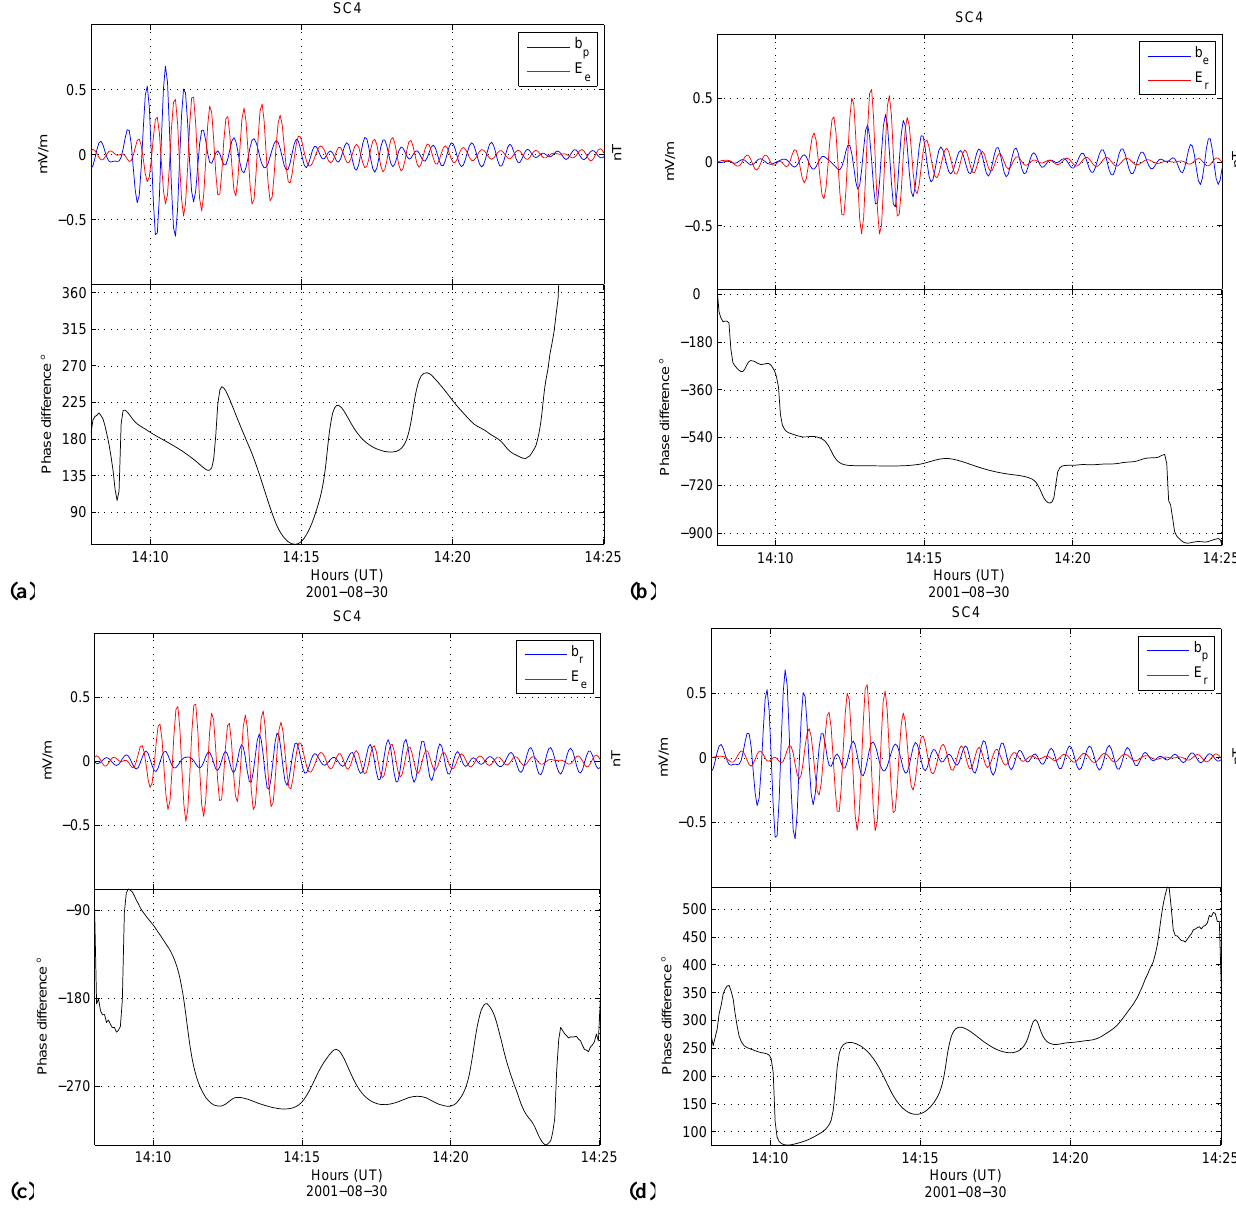
Fig. 8. Same as Fig. 7 but bandpass filtered with passband 22–32mHz. for the first five or six wave periods and then the amplitude starts to decrease. The magnetic field component does not show the same rate of increase as the electric field compo- nent. The phase difference between the two components is approximately 180 ◦ for the first two or three wave periods and then it rapidly changes so that the two components are 90 ◦ out of phase. Interestingly, as soon as the two com- ponents become 90 ◦ out of phase the amplitude of the b e component increases rapidly and is then correlated with the amplitude of the radial electric field. For the b r component